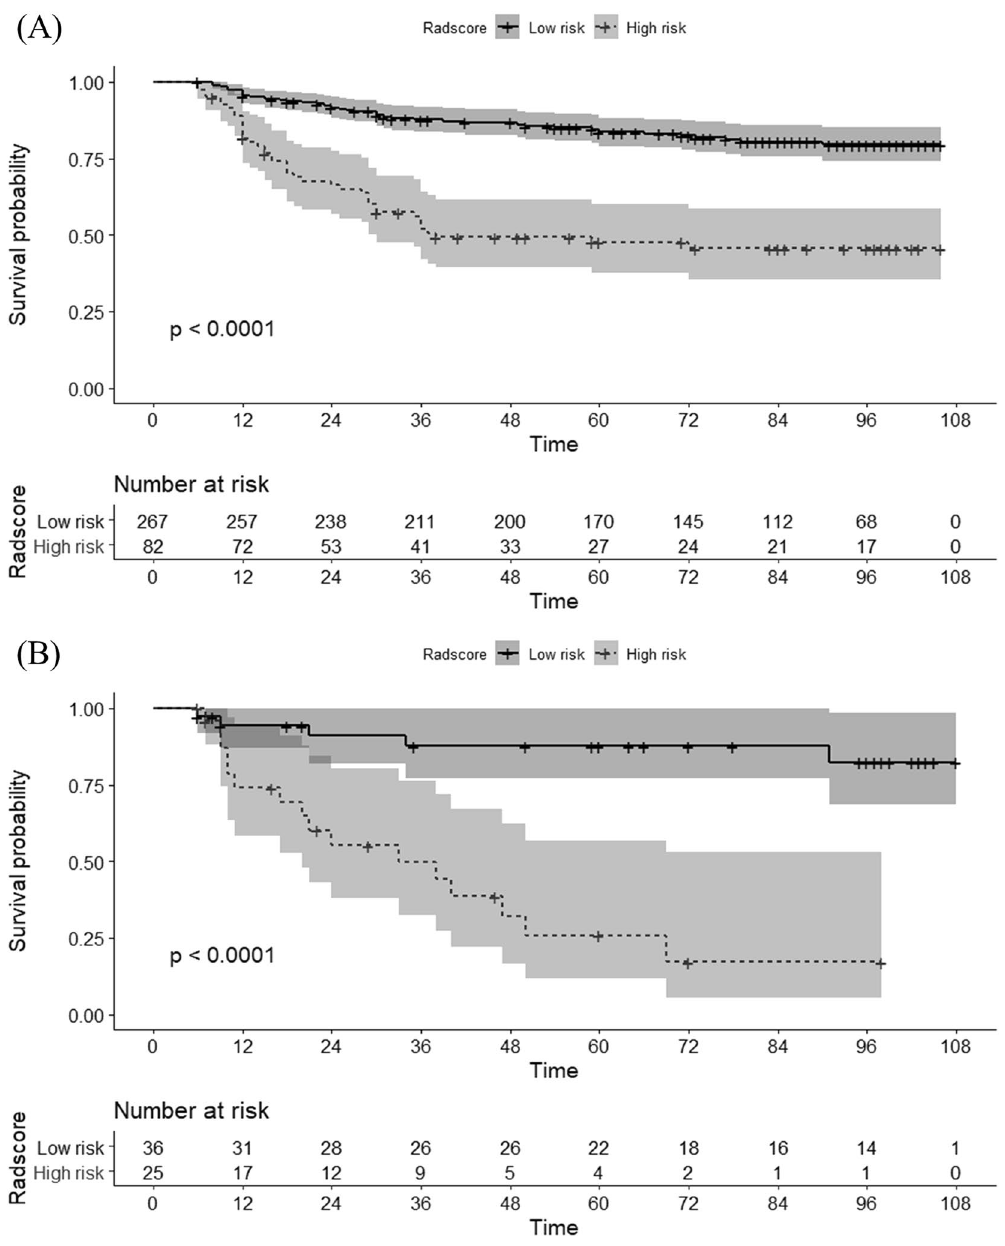
Figure 3. Kaplan–Meier curves and risk tables for recurrence-free survival (RFS) from ( A ) the training (n = 349) and ( B ) validation (n = 61) cohorts. Patients were stratified on the basis of the cutoff (radscore = 1.164) to maximize log-rank statistic. The radiomics score significantly stratified the patients into low- and high-risk groups for RFS in the training cohort ( p < 0.001; log-rank test) and the validation cohort ( p < 0.001; log-rank test). Shaded areas represent 95% confidence intervals. R software (version 3.3.2, https ://www.r-proje ct.org) was used to